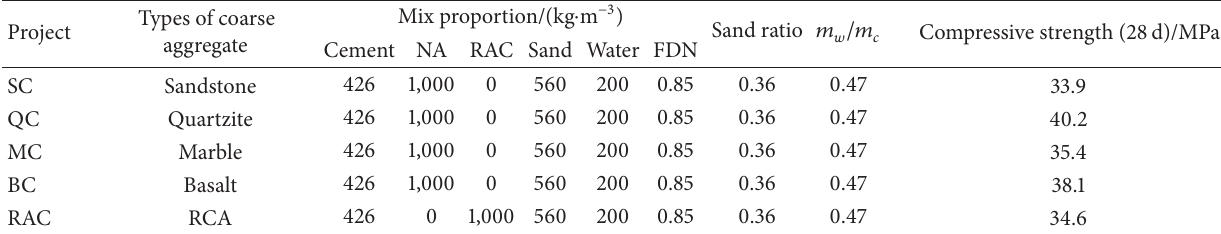
Table 2: Mix proportion and compressive